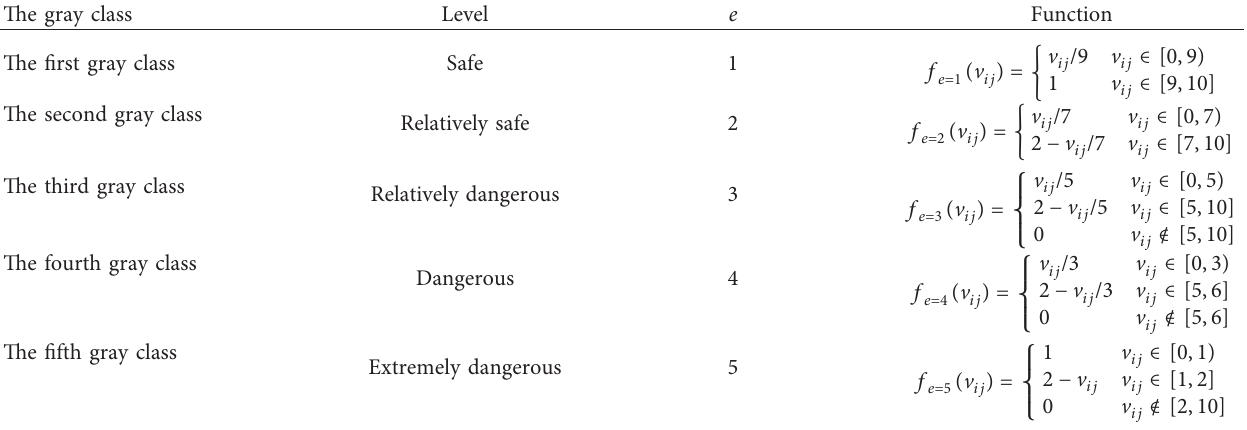
Table 3: Gray whitening weight